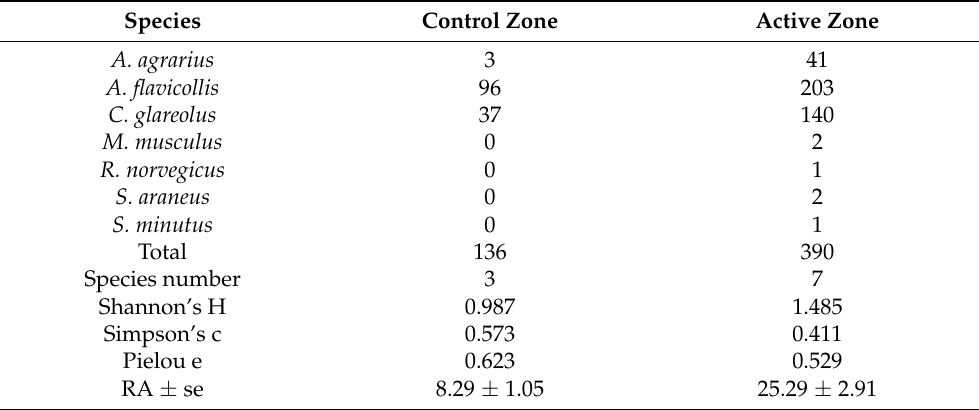
Table 3. Small mammal community structure, diversity, and relative abundance in Naudži¯unai cormorant colony, 2016–2022. Species Control Zone Active Zone A. agrarius 3 41 A. flavicollis 96 203 C. glareolus 37 140 M. musculus 0 2 R. norvegicus 0 1 S. araneus 0 2 S. minutus 0 1 Total 136 390 Species number 3 7 Shannon’s H 0.987 1.485 Simpson’s c 0.573 0.411 Pielou e 0.623 0.529 RA ± se 8.29 ± 1.05 25.29 ±